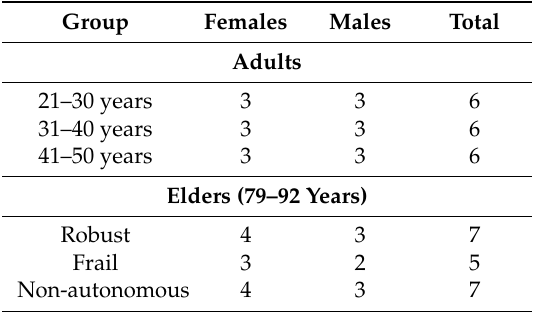
Table 1. Classification of enrolled individuals based on their age and frailty status. Samples of a total number of 18 adults and 19 elders were